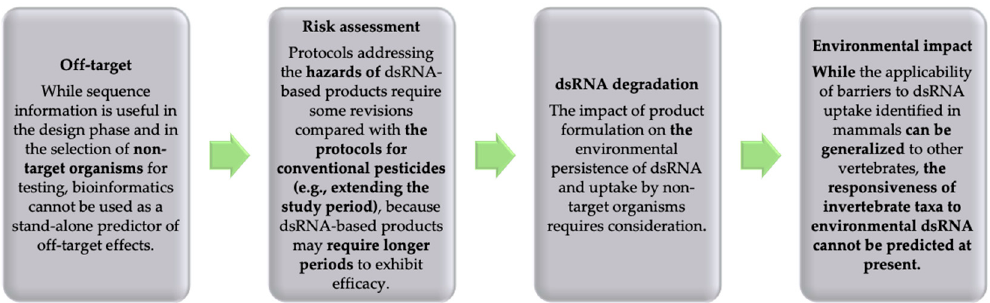
Figure 2. Key aspects and considerations related to the use of RNAi-based pesticides discussed at the conference held by the Organization for Economic Cooperation and Development (OECD) (adapted from Mendelsohn et al. [76]).